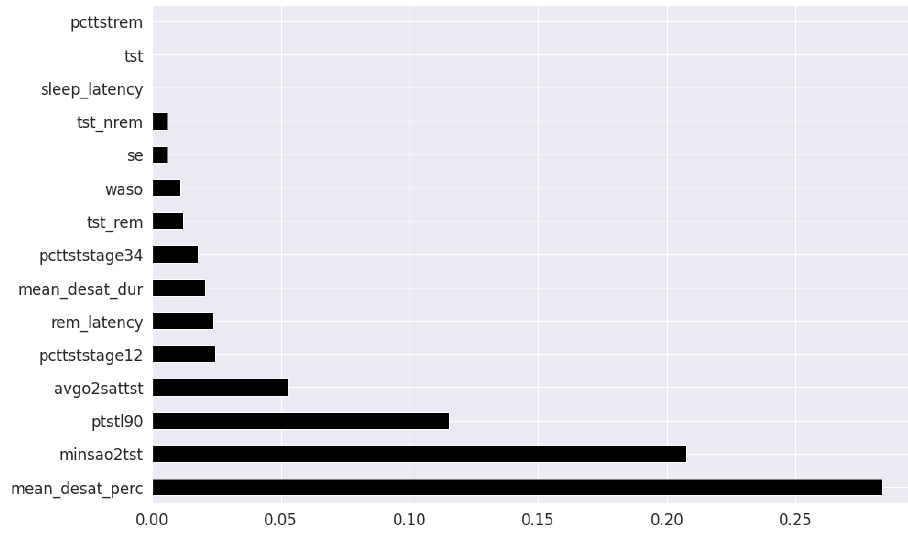
Figure 8. PSG features ordered as per Mutual